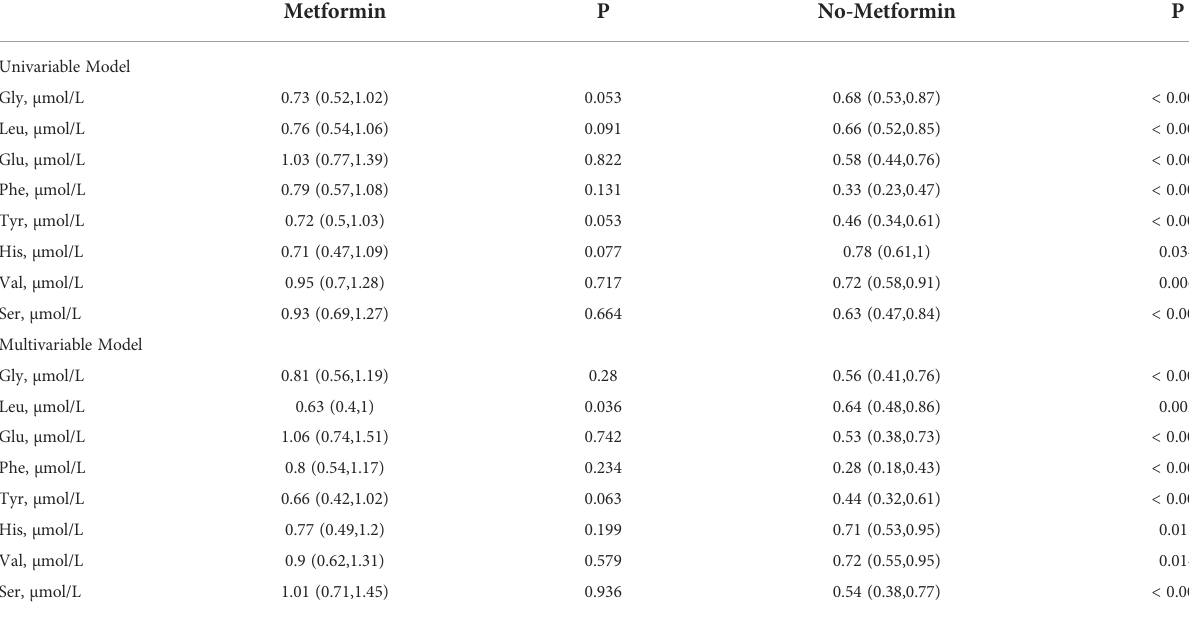
TABLE 4 Logistic regression of different amino acids and DR under the action of